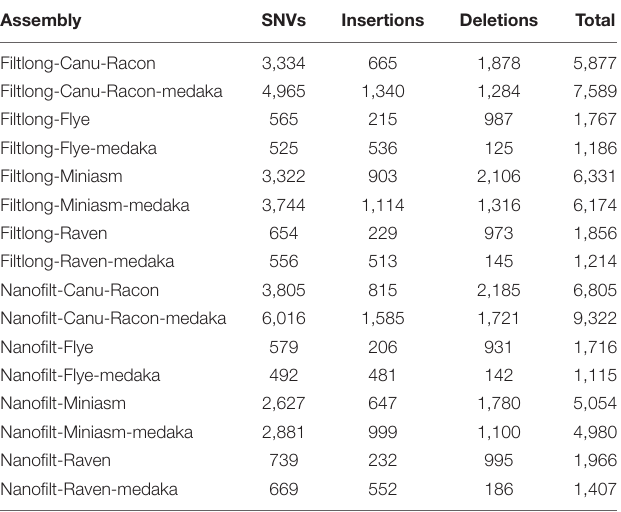
TABLE 4 | The mean number of single nucleotide variant (SNVs), insertions and deletions detected from whole genome alignments for each LR assembly against the appropriate Unicycler reference.